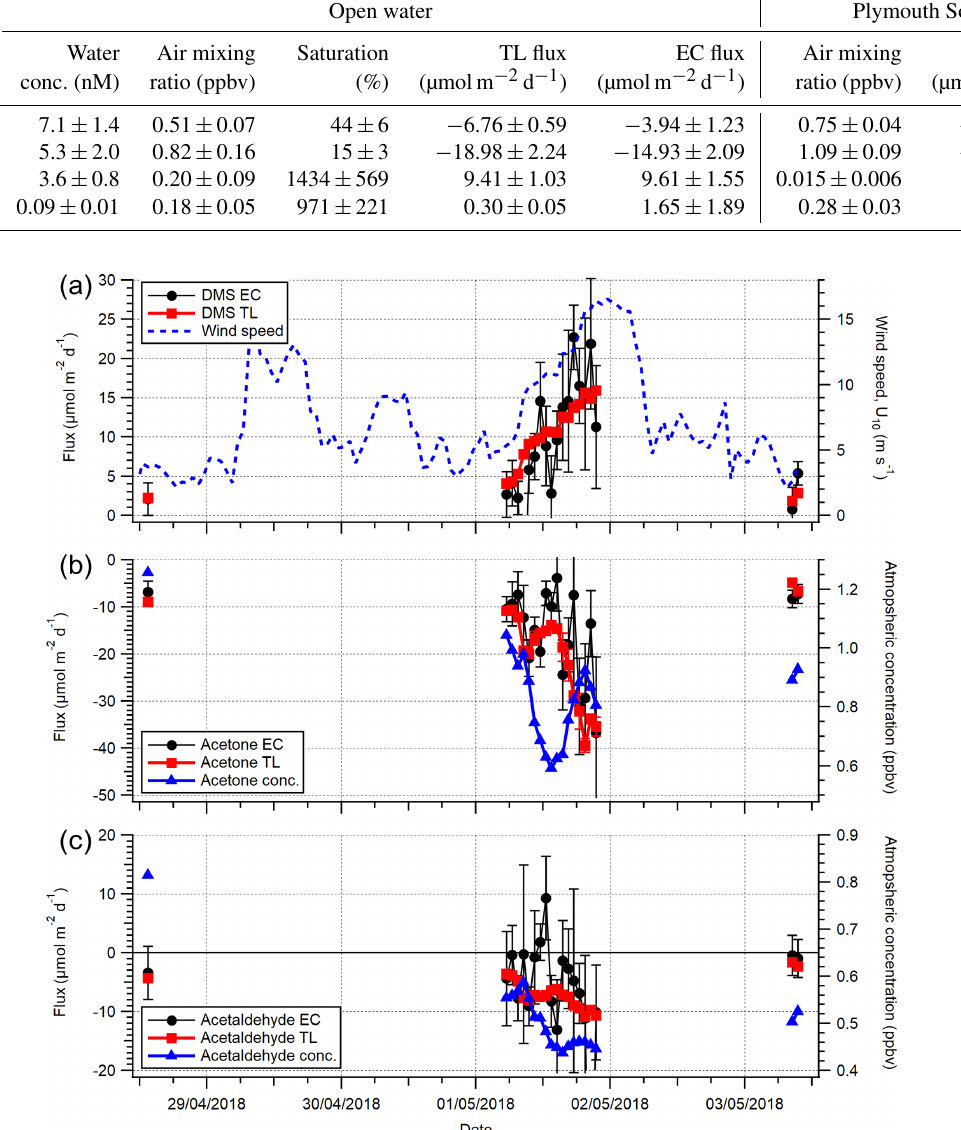
Figure 6. A comparison between (a) DMS, (b) acetone and (c) acetaldehyde EC and TL fluxes (hourly) for the open-water sector during the dates 27 April–3 May 2018. Wind speed ( U 10 ) is provided in (a) . The error on EC measurements is 1SE, whilst the error on TL is the propagated error of 1SD in concentration and